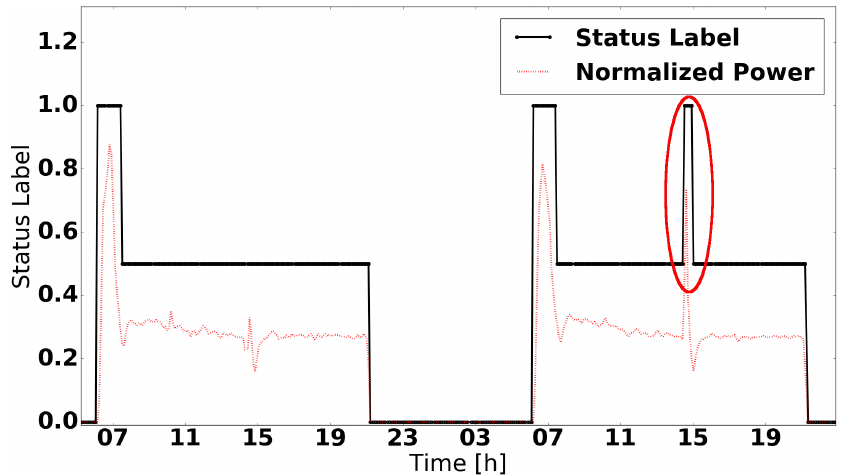
Figure 4. Status detection with outlier value identification.